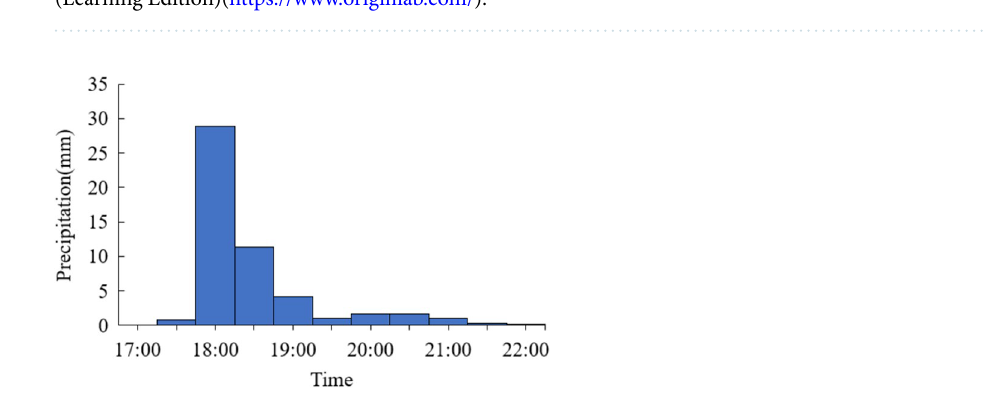
Figure 5. Rainfall event in the case area on May 31, 2021. This graph was generated with OriginPro 2021 (Learning Edition)(https:// www. origi nlab.